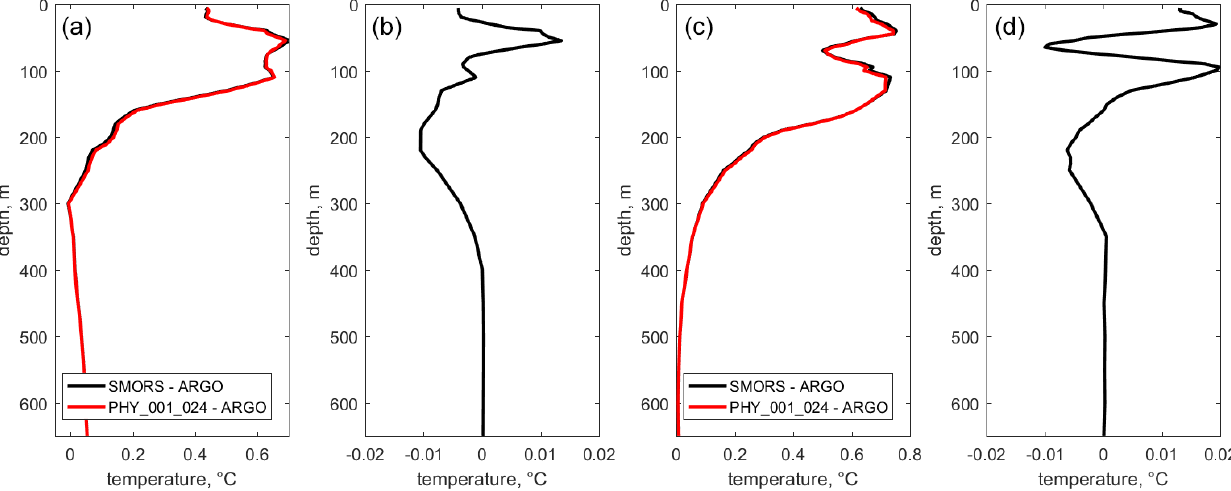
Figure 8. Annually averaged biases (a) and RMSEs (c) of temperature for the two models: PHY_001_024 – ARGO (dashed line) and SMORS-3D – ARGO (solid line). Panels (b) and (d) show the zoomed-in differences between the lines in (a) and (c)